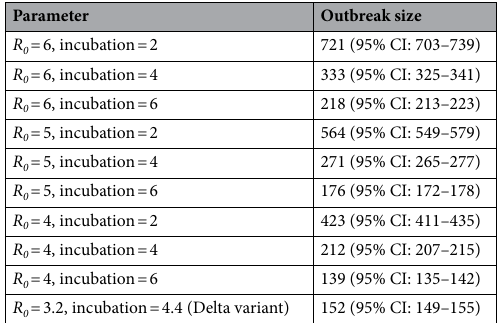
Table 2. Outbreak size using Guangzhou interventions for more threatening SARS-CoV-2 variants.